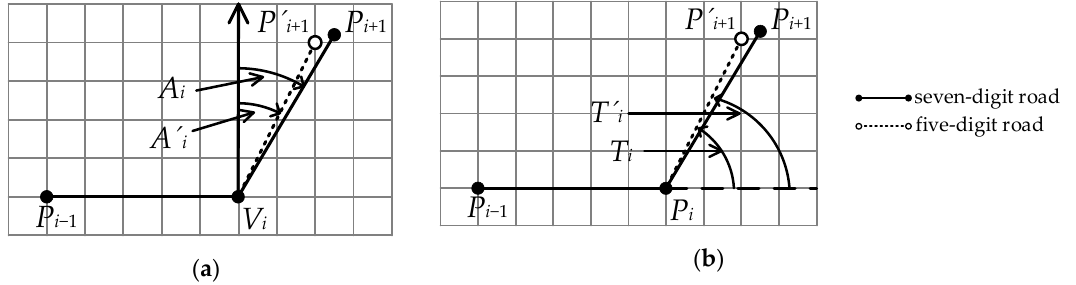
Figure 4. Spatial directional relationship with di ff erent precision: ( a ) the azimuth of segment V i P i + 1 at node V i ; ( b ) the turning angle between two sequential road segments at vertex P i .